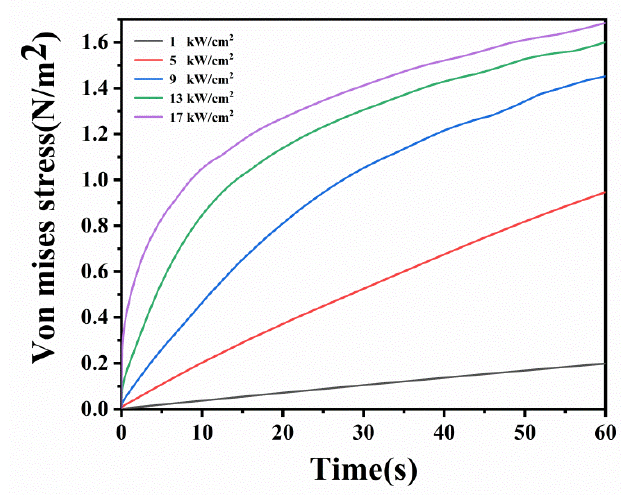
Figure 7. Schematic diagram of the variation of the Von Mis stress ( σ v ) at the center of the laser beam at the laser power densities of 1000, 5000, 9000, 13,000 and 17,000 W/cm 2 .